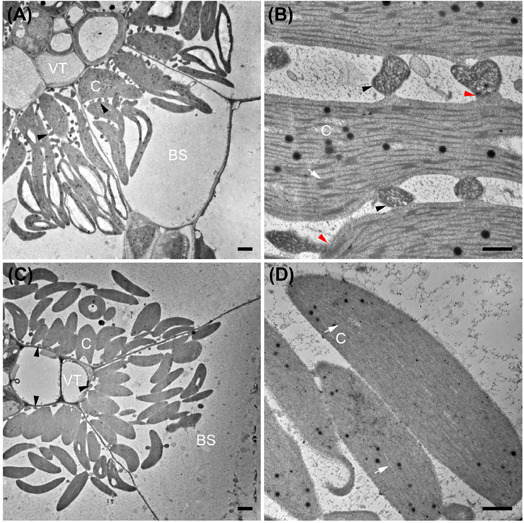
Transmission electron micrographs of bundle sheath cells (A,C) and bundle sheath chloroplasts (B,D) from NAD-ME subtype Portulaca oleracea
(A,B) and NADP-ME subtype Portulaca pilosa
(C,D). Red arrowheads mark mitochondria to chloroplasts connection structures in P. oleracea
(B). BS, bundle sheath; C, chloroplast; VT, vascular tissue; black arrowheads mark mitochondria; white arrows mark thylakoids. Bars = 2 μm (A,C) or 0.5 μm (B,C).